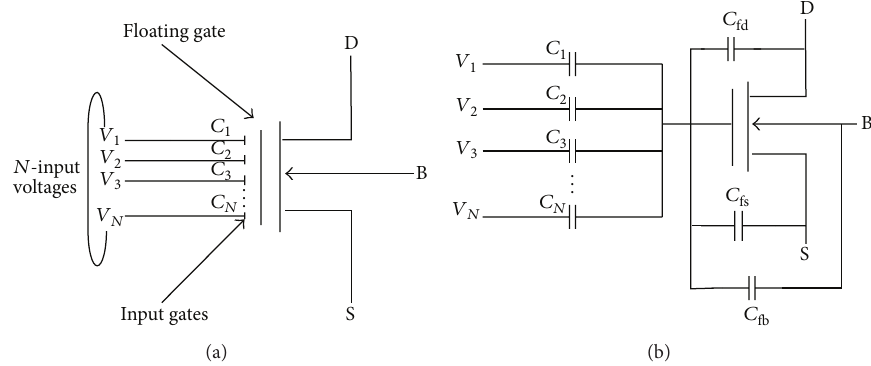
Figure 2: The symbol (a) and equivalent circuit model (b) of an N-type, 𝑁 inputs